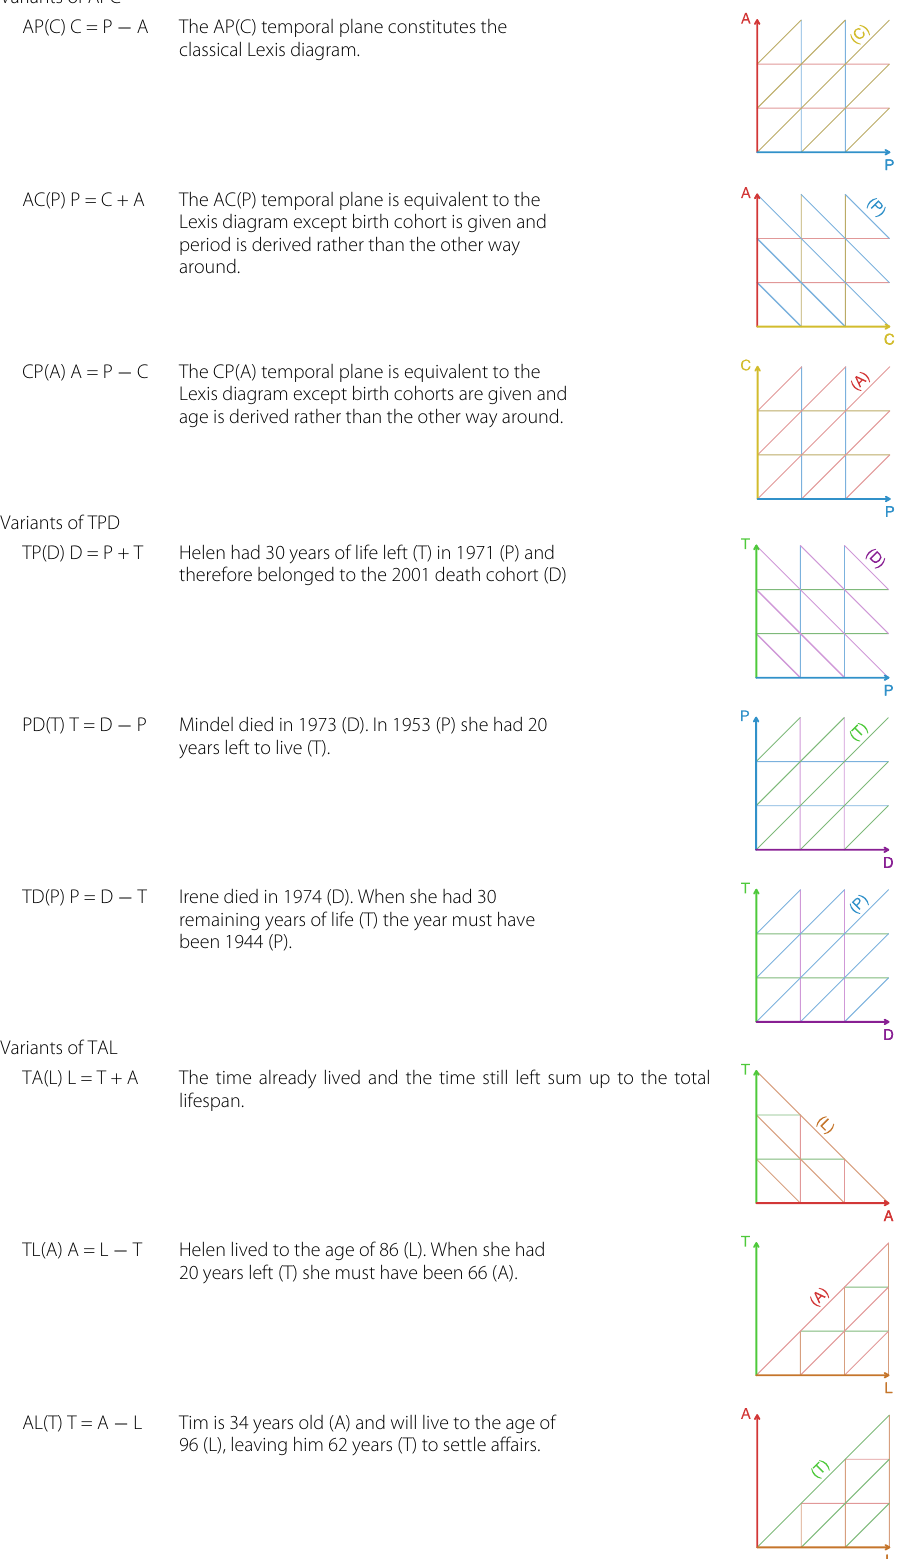
Table 2 All dyadic juxtapositions of the six measures of demographic time Variants of